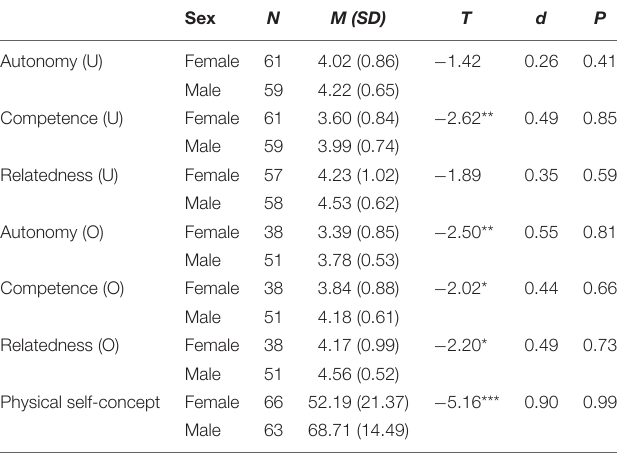
TABLE 5 | Satisfaction of basic psychological needs and self-concept for male and female students.